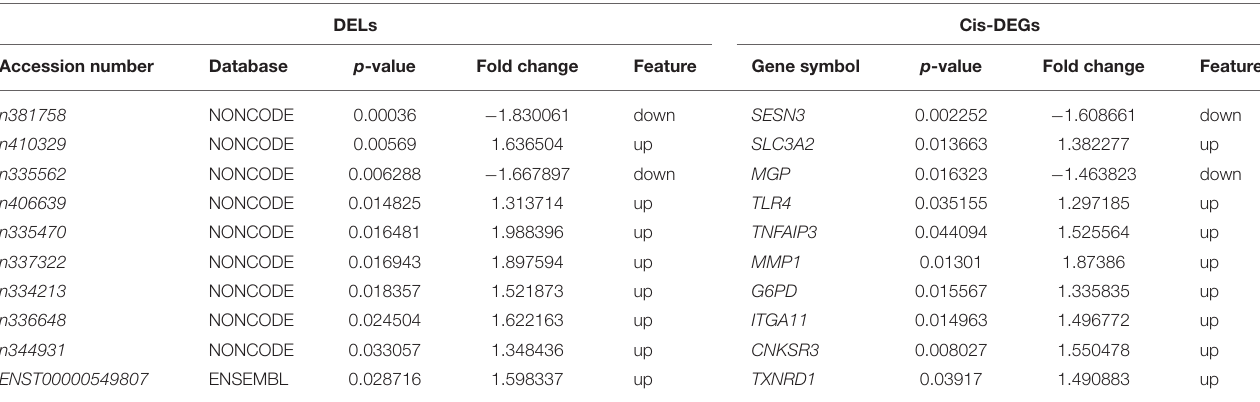
TABLE 1 | Cis-Analysis of differentially expressed